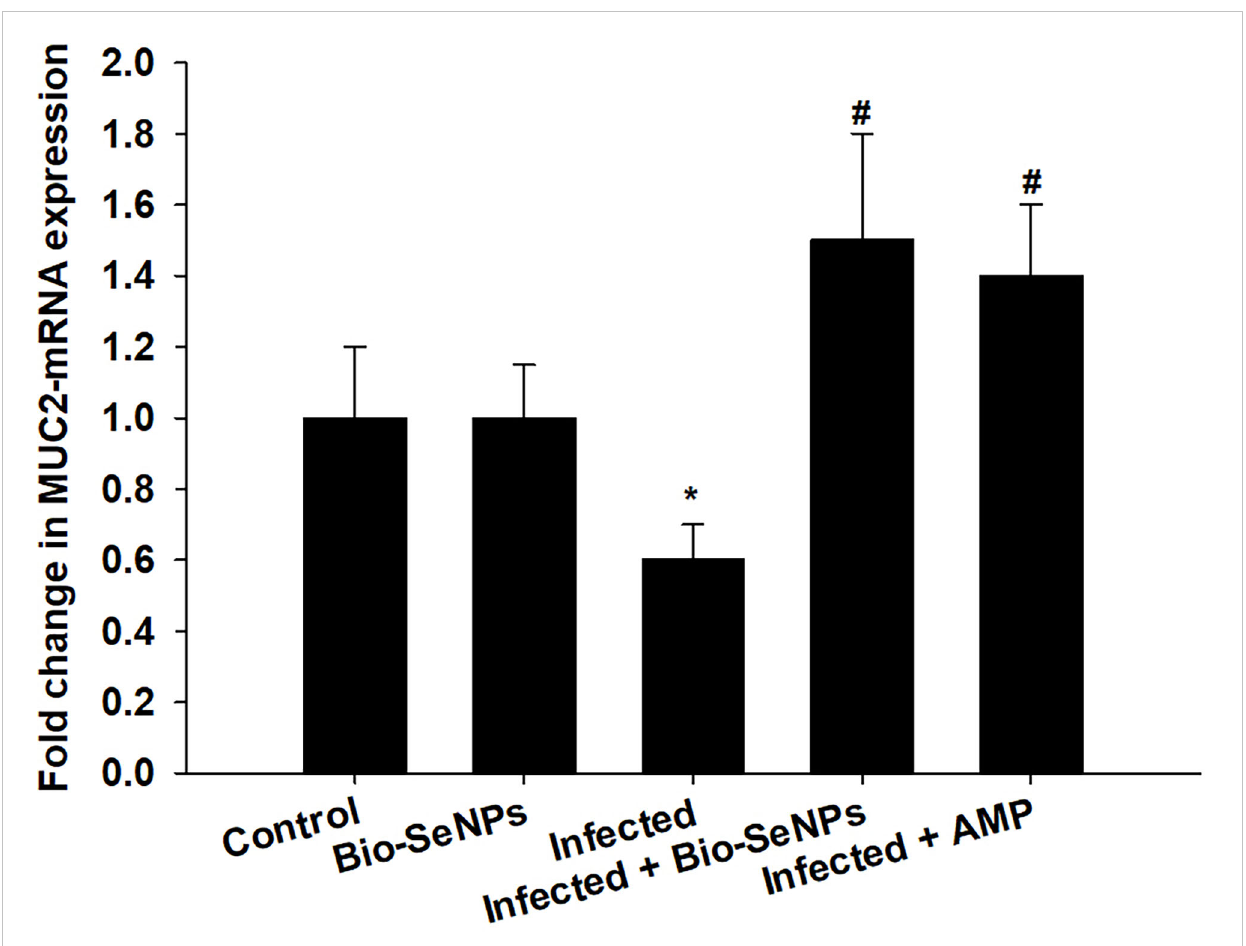
FIGURE 9 Effect of Bio-SeNPs on the mRNA expression of MUC2 in the jejunal samples from E. papillata -infected mice. The expression values obtained by RT- PCR analysis were normalized to the reference gene GAPDH mRNA level and are shown as fold induction (in log 2 scale) relative to the mRNA level in the control. * signi fi cance changes concerning the control group, # signi fi cance changes concerning the infected group.